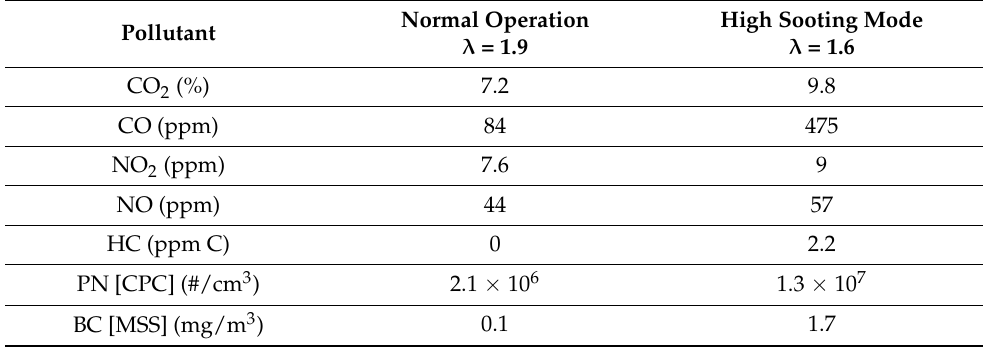
Table 1. Exhaust gas content of individual pollutants in Normal Operation and High Sooting